Question: Condense the content of this figure into a single sentence.
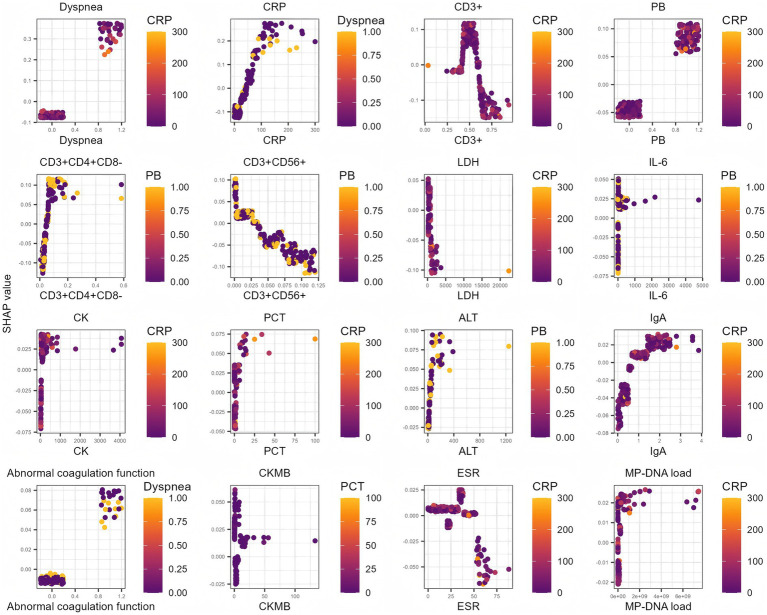
Answer: SHAP dependency plots for various clinical and laboratory indicators. This set of figures quantifies and visualizes the independent contributions of 16 clinical/laboratory indicators [such as dyspnea, C-reactive protein, total T lymphocytes, and sputum plug formation (PB)] to the prediction of severe illness risk, as well as their interactions with key features [such as C-reactive protein, sputum plug formation (PB), and procalcitonin]. The horizontal axis represents the value of the feature itself, and the vertical axis represents the SHAP value (positive contributions increase the risk of severe illness, while negative contributions decrease the risk). Color coding associates the value of another key feature (yellow represents a high value of the key feature, and purple represents a low value).